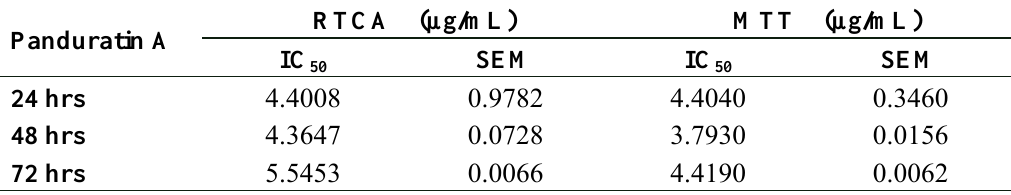
Table 1. IC values (µg/mL) at 24, 48 and 72 hours for panduratin A on A549 50